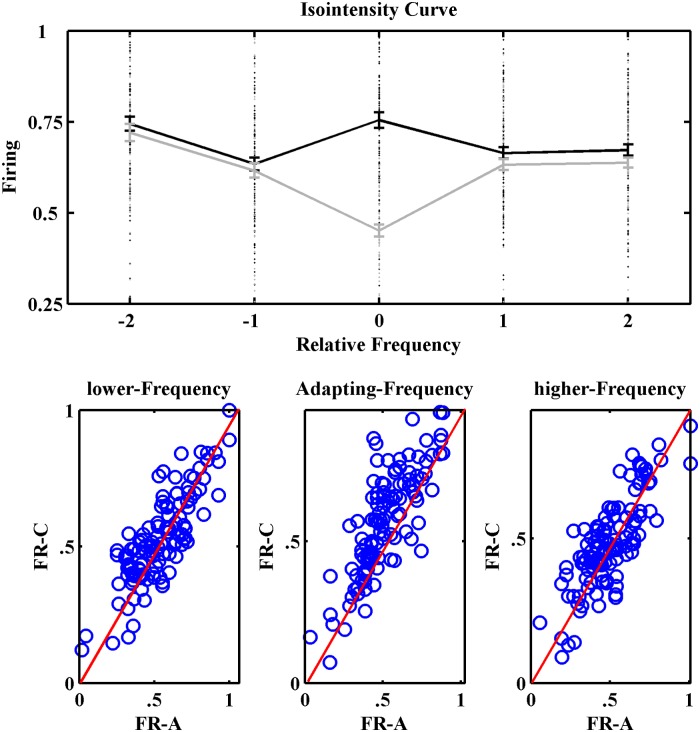
Isointensity curve and comparison between the responses of stimuli in the control and adaptation sequeces for the population of neurons.A. The population isointensity curve of 167 neurons that their firing rates were normalized and they were aligend to each other according to their adapter and four neighboring frequencies. Error bars are the standard error of the mean (s.e.m.). B. The scatter plots show the firing rate in control sequence vs. adapting sequence and the histogram of neural response changes for the adapted frequency (middle plot) and higher and lower neighboring frequencies in 60 dB. Dots indicate the neural responses of each neuron averaged across trials. Each dot placed upper the red line, demonstrates that the firing rate of that neuron in control sequence (FR-C) is more than the firing rate of it in adapting sequence (FR-A).